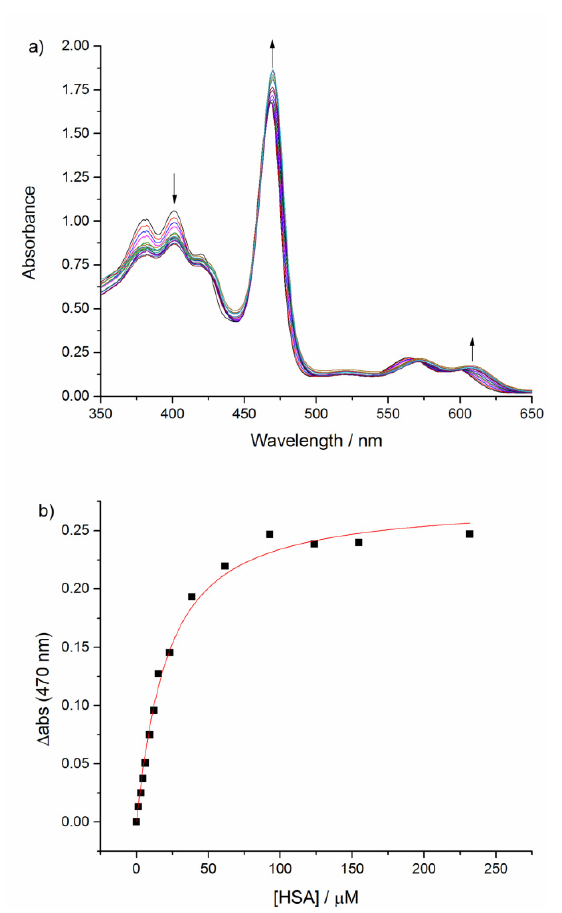
Figure 3. ( a ) UV absorbance spectra of 7.7 μ M m -MnP2 titrated against 0–15 eq. of human serum albumin (has) in 25 mM pH 7.2 HEPES buffer at 25 °C. ( b ) The change in UV-Vis absorbance at 470 nm was plotted and fitted using OriginLab ® 9.0 to obtain a dissociation constant K d of 16.5 ± 1.5 μ M (see supporting information for details).